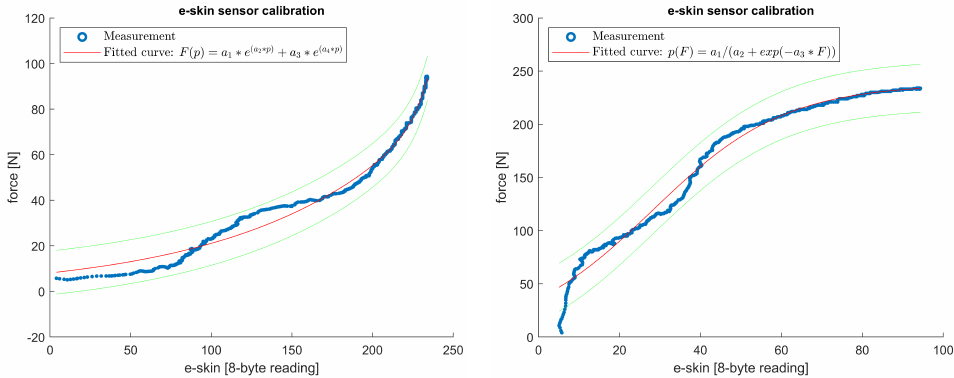
Figure 12. Example plot of curve fitting for measurements in the unloading phase of the e-skin sensor from row 14, column 25. On the left is the fit according to formula (1) and on the right according to formula (2). Green lines indicate the 95% confidence interval.